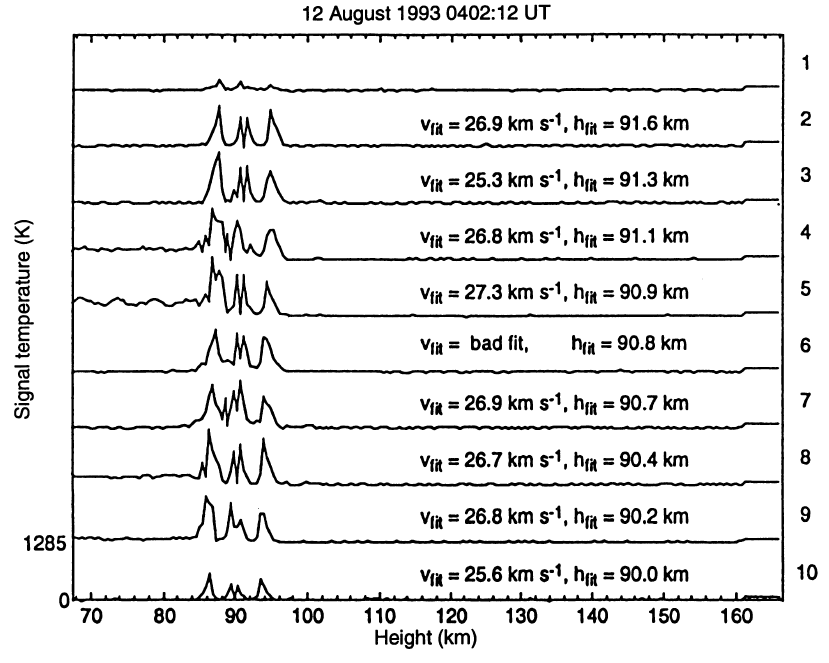
Fig. 9. A. Perseid-time head echo resolved in 6 ms time-slices. The meteoroid passed the radar beam within about 60 ms. From such data the meteoroid descending process can